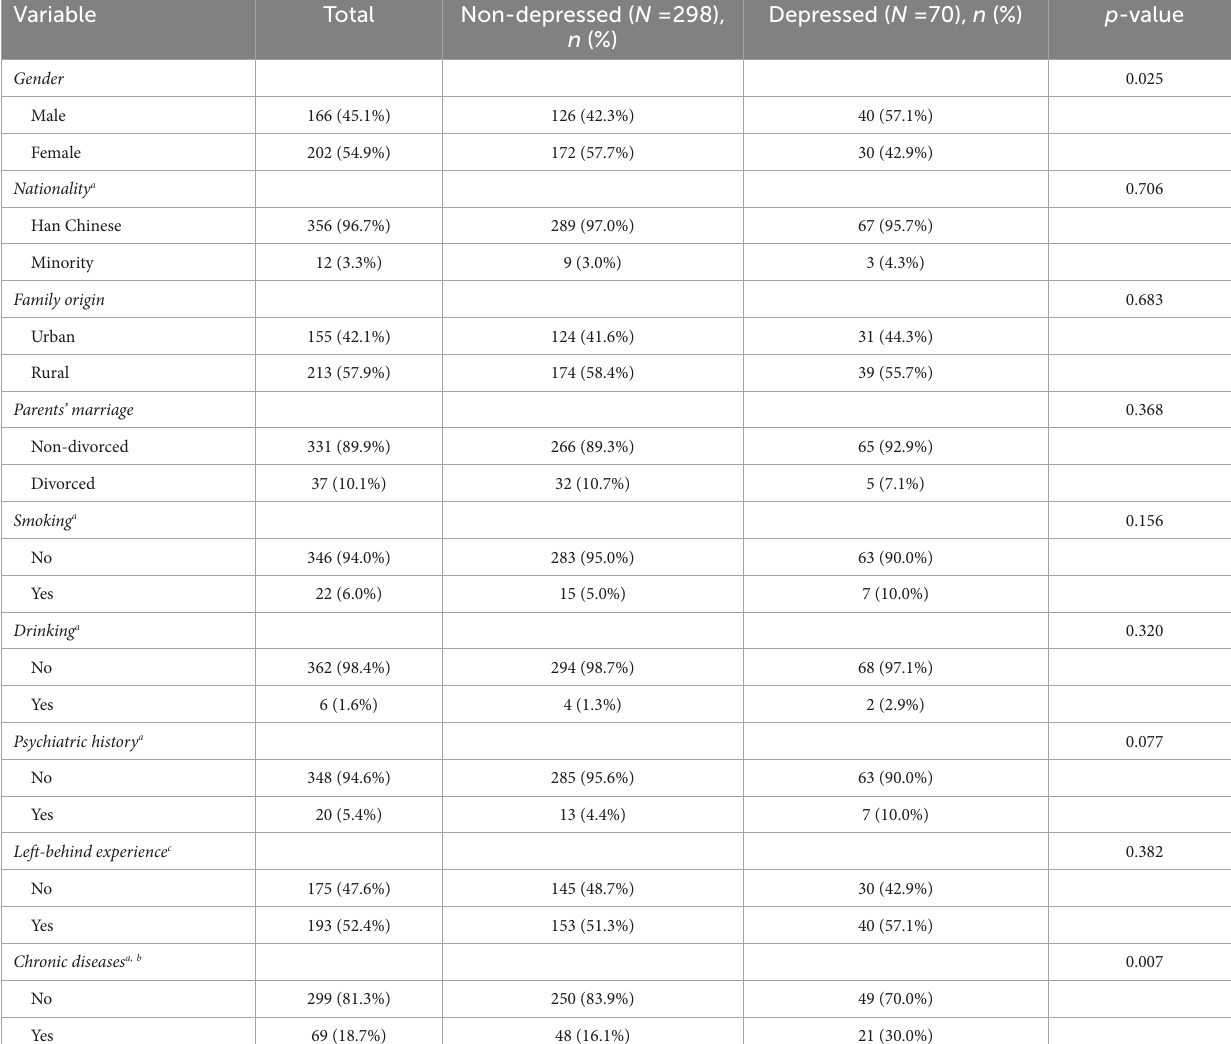
TABLE 1 Characteristics of participants according to PHQ-9 scores >9 ( N = 368).